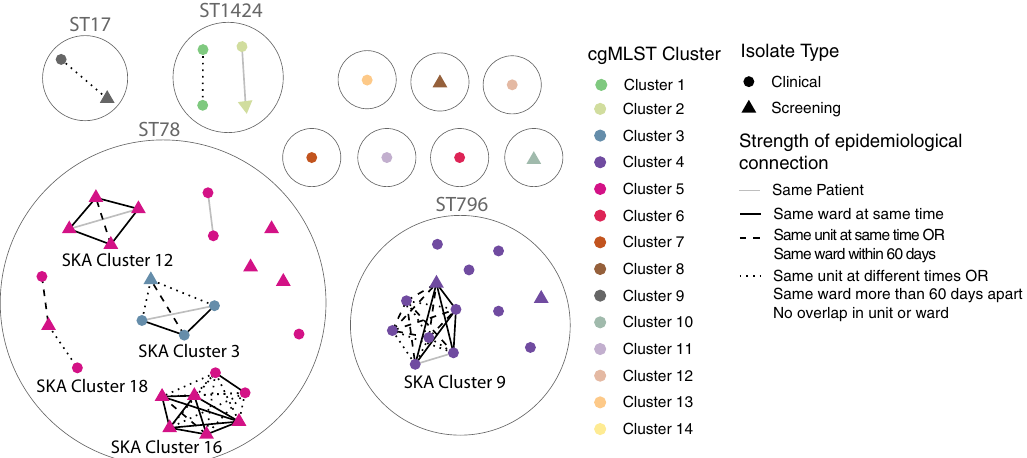
Fig. 5 Transmission networks identi fi ed in the hospital case study. Network diagram of genomics transmission links of all isolates involved in the hospital case study. Each node represents one case and are coloured by their respective core genome multilocus sequence type (cgMLST) cluster. The shape of each node identi fi es if the isolate was collected as patient screening or as a clinical sample. Nodes are grouped in grey circles based on their sequence type (ST) (only STs with more than one isolate have been labelled). Lines between nodes are present if the split kmer analysis (SKA) pairwise distance between isolates is ≤ 7 single nucleotide polymorphisms (SNPs) and the line type represents the strength of epidemiological link between the isolates. SKA clusters with more than 3 isolates have been